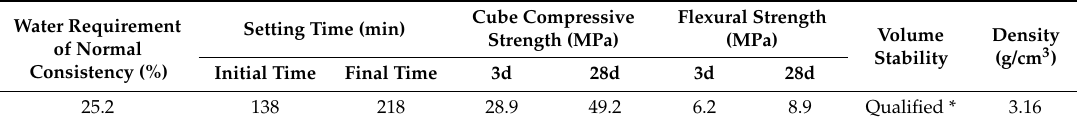
Table 2. Properties of cement.